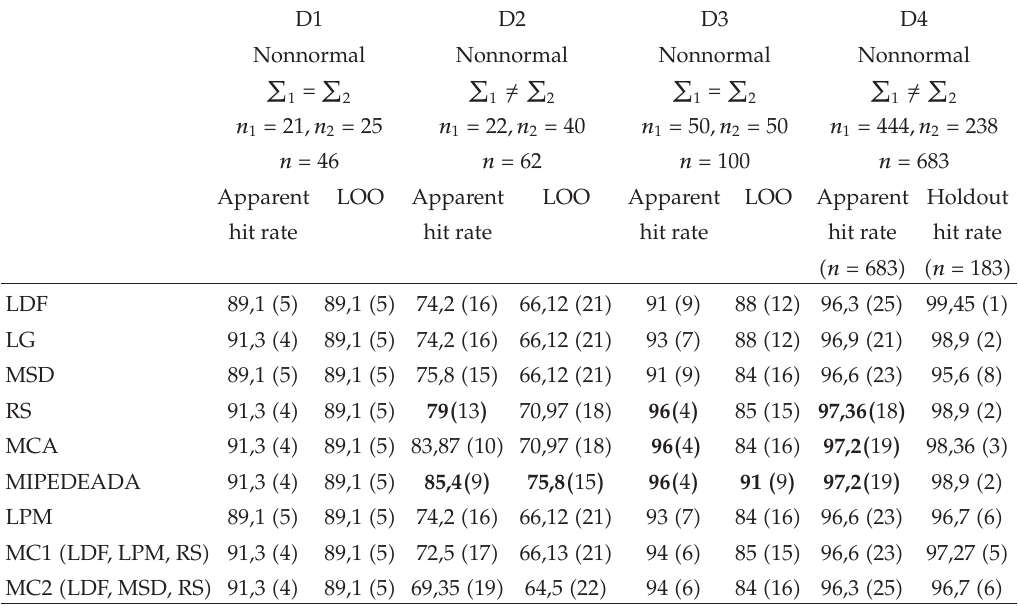
Table 6: The apparent, the LOO, and the holdout sample hit rates (cid:2) in percentage (cid:3) of the di ff erent models.